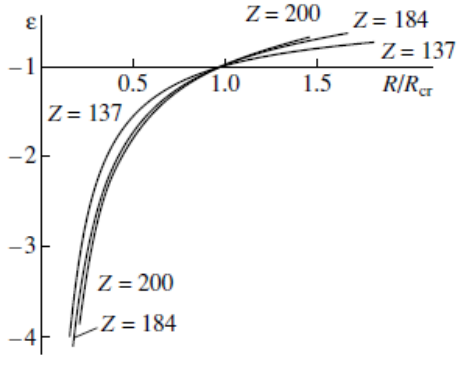
Figure 4. Solution (cid:101) ( R / R cr ) of Equation (130) for various values of the parameter ζ